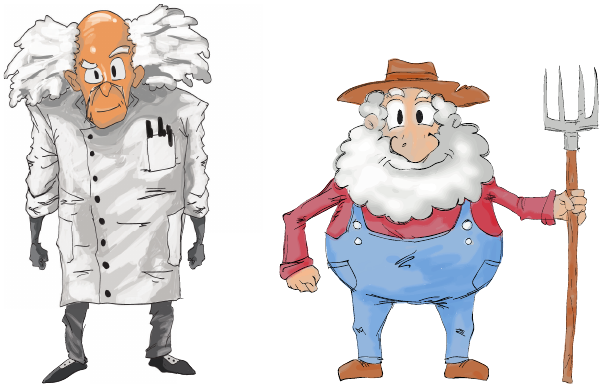
Figure 3: Concepts of Dr. Jacob and Tom A. Toe created by the 2D